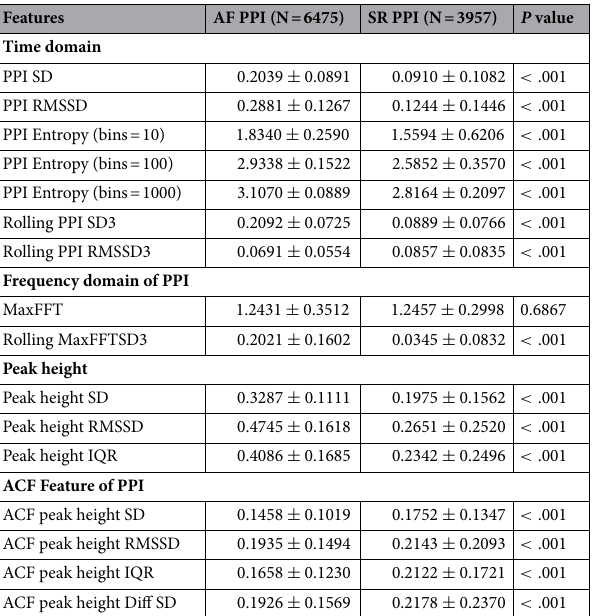
Table 2. Univariate analysis of PPG features of 25-beat PPI segments between AF and SR PPI.